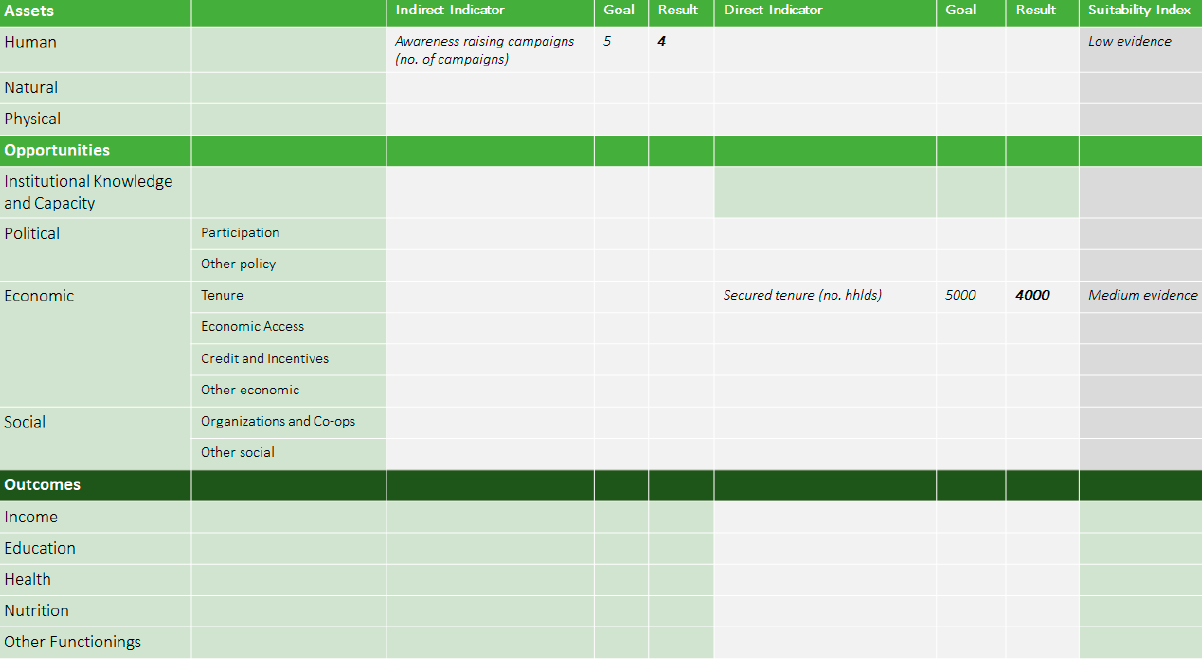
Figure 3. Framework developed for the evaluation of the socio-economic impacts of GEF-funded, and similar, SLM interventions. This includes some example indicators, goals, measured results and examples of the suitability index.